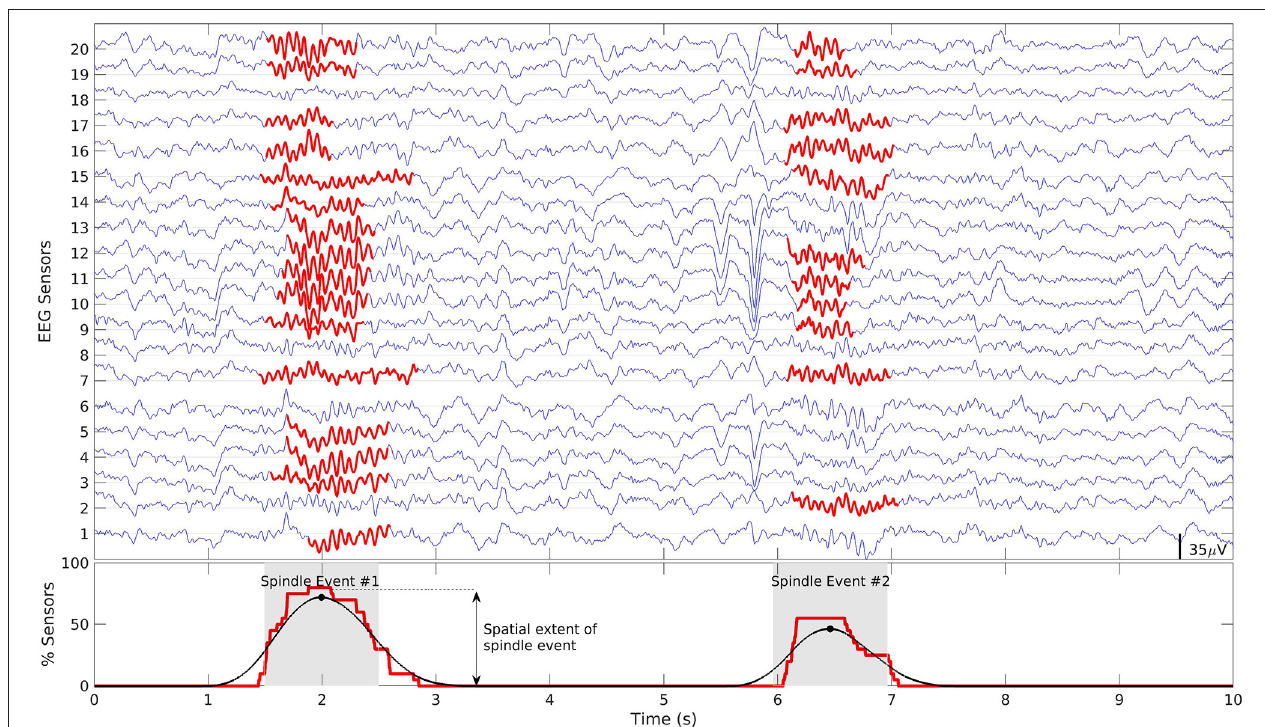
FIGURE 2 | Definition of spindle events. Top: Example of 10s of N2 signal from 20 EEG electrodes. Detected spindles at each sensor are highlighted in red. Bottom: The raw aggregate signal (red) and smoothed signal (black). Spindle events were defined as 1s time-windows around the peaks of the smoothed signal (gray patch). The maximum amplitude within this window reflects the spatial extent of the detected spindle event. The same definition applies to MEG sensors and source space analyses.